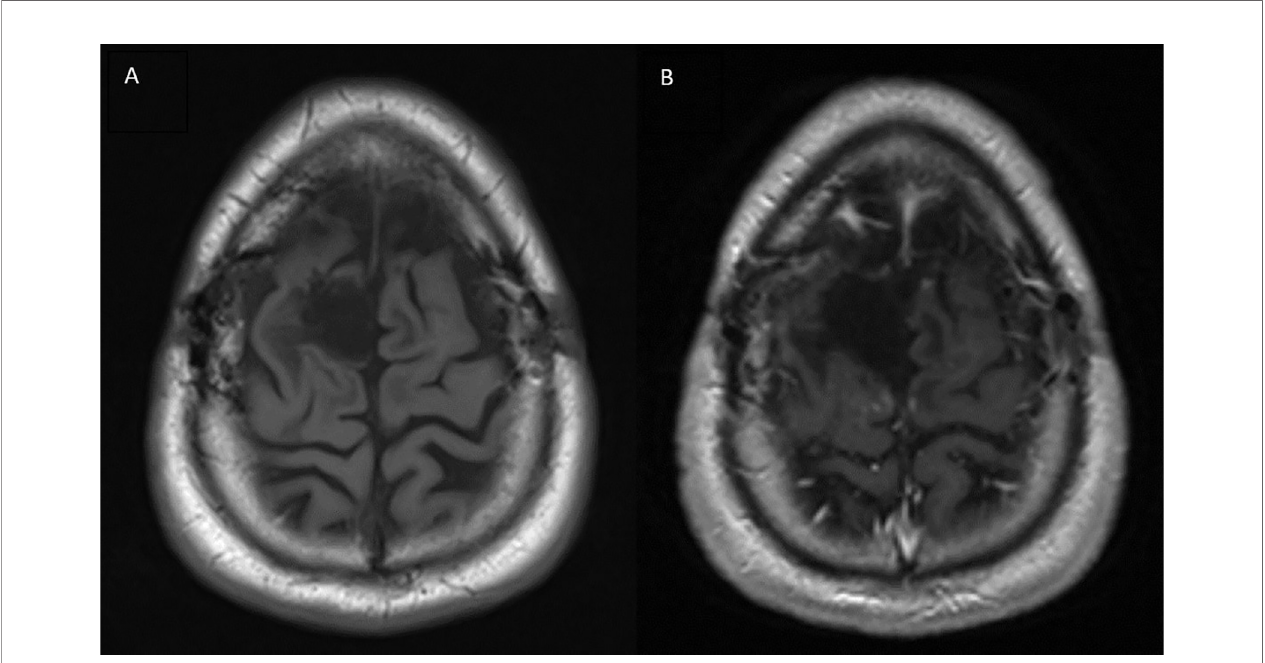
FIGURE 3 | Brain MRI performed 34 months after completion of radiotherapy treatment. (A) T1 pre-contrast (B) T1 post-contrast showing no areas of peripheral or nodular